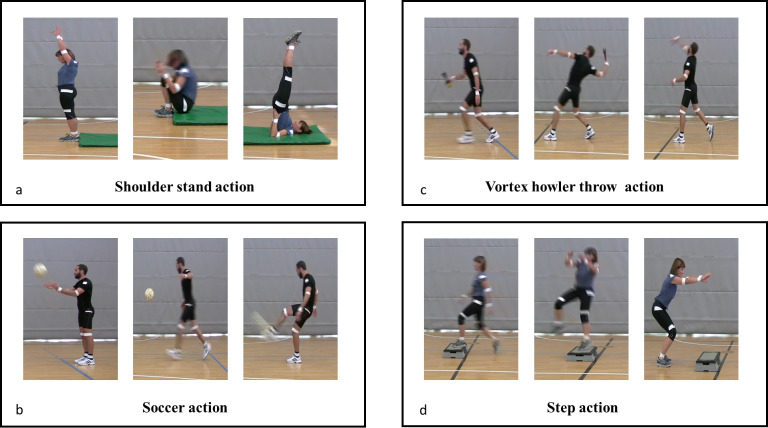
Sport actions investigated in the project.The Figure is representing the four actions investigated, showing the three main moments of each: Starting, intermediate and final phase.